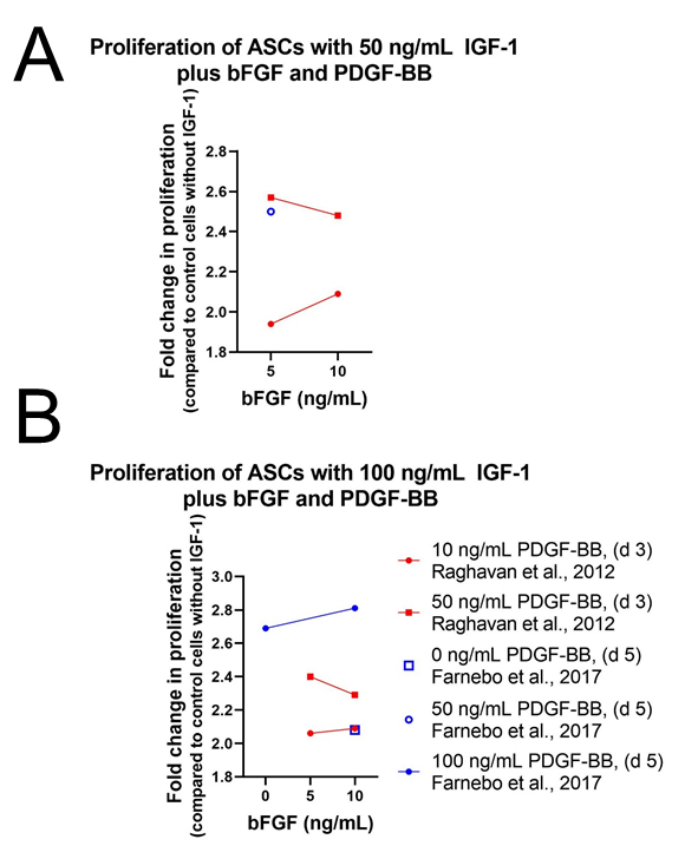
Figure 6. Impact of basic fibroblast growth factor (bFGF) concentration on the proliferation of ASCs in the presence of 50 ng/mL IGF-1 ( A ) or 100 ng/mL IGF-1 ( B ), respectively. Further information: Human ASCs in Ham’s F12 containing 0.2% BSA [77]; rat ASCs in ECM-solution containing 10% FCS [79].